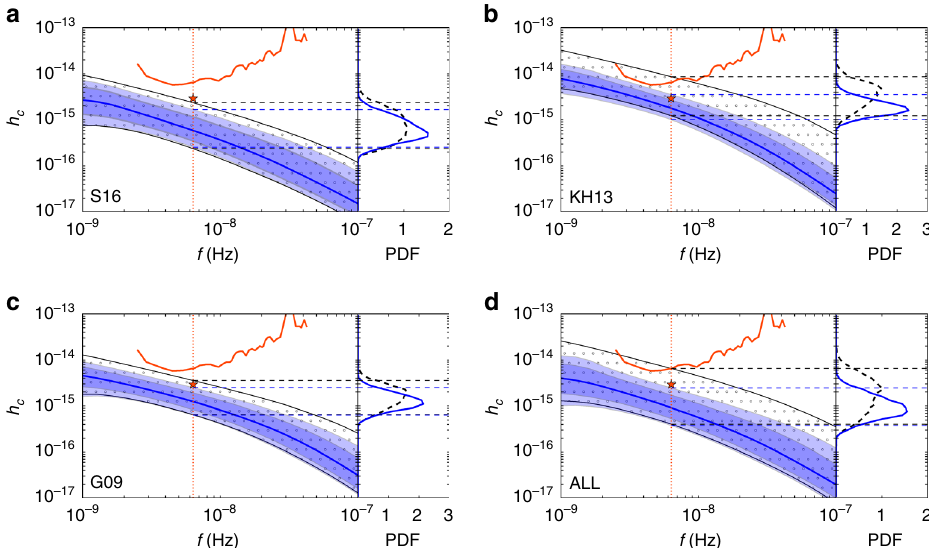
Fig. 1 The posterior density function on the gravitational wave characteristic amplitude. The four panels compare the prior and posterior density functions on the GW stochastic background characteristic amplitude in light of the PPTA upper limit for each of the astrophysical models considered here: a S16; b KH13; c G09; d ALL. The central 90% region of the prior is indicated by the black dotted band and the posterior is shown by the progressively lighter blue shading indicating the central 68% and 90% regions, respectively, along with the median (solid blue line). Also shown are the PPTA bin-by-bin limit (orange solid line) and the corresponding integrated limit assuming h c ( f ) ∝ f − 2/3 (orange star and vertical dotted line). The difference in the prior and posterior indicates how much has been learnt from the PPTA data. In each panel, the right-hand side one-dimensional distribution shows the prior (black dashed) and posterior (blue solid) at a reference frequency of f ~ 1/5 yr − 1 , with the central 90% regions marked (black and blue dashed lines